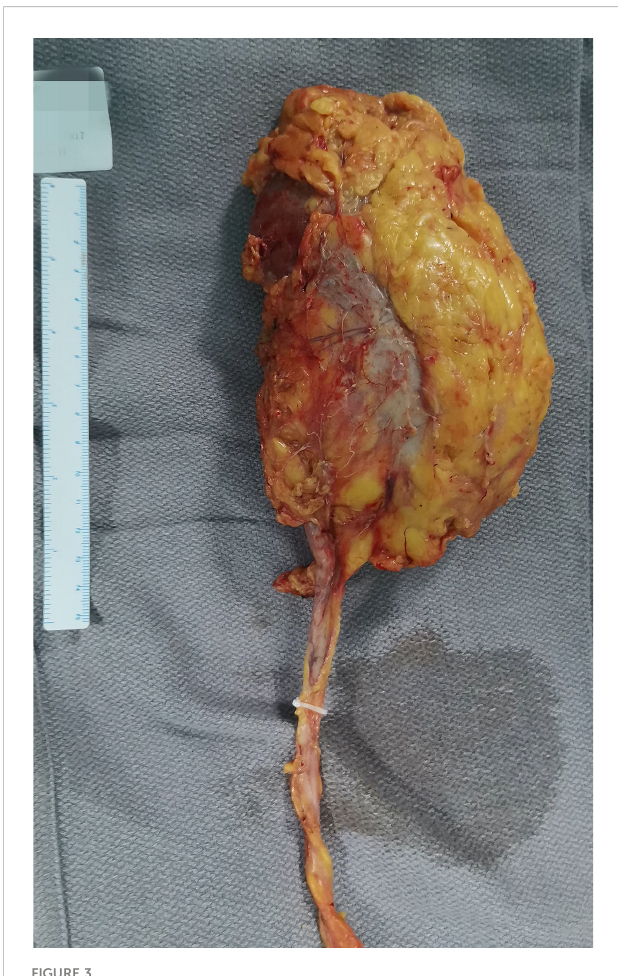
FIGURE 3 The gross specimen. The right middle ureter was blocked with a Hem- o-lok clip, which avoided the spread and over fl ow of tumor and pus into the lower urinary tract during the